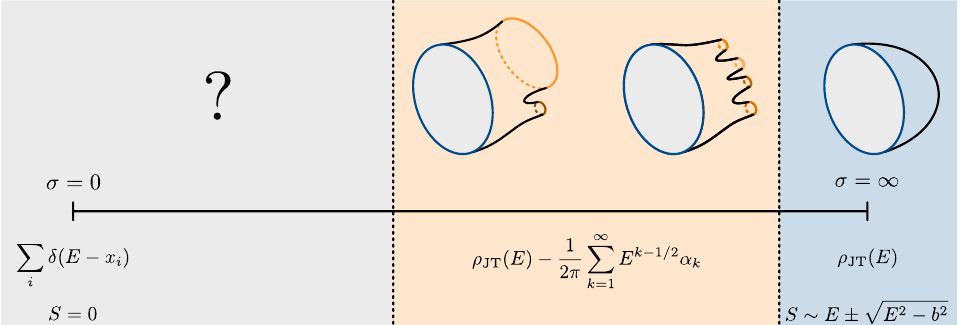
Figure 1: Phase diagram of the matrix integral (1) and its gravitational interpretation as a function of σ . On the far right (blue region), we have σ “ 8 and our matrix model is that for JT gravity. We also added the saddle for the Efetov sigma model in the Gaussian model at σ “ 8 . As we move away from σ “ 8 we enter in the orange region, where the matrix model is deformed by (ghost) brane insertions that are labelled by the eigenvalues x of the target Hamiltonian H (the different shades of i 0 orange on the small boundaries is supposed to represent that). The spectral density is given as well in this region with α given in 108. As σ is decreased further in k the orange region the model goes through a series of tearing phase transitions [ 64 ] , which is manifested geometrically by very large boundaries ending on the